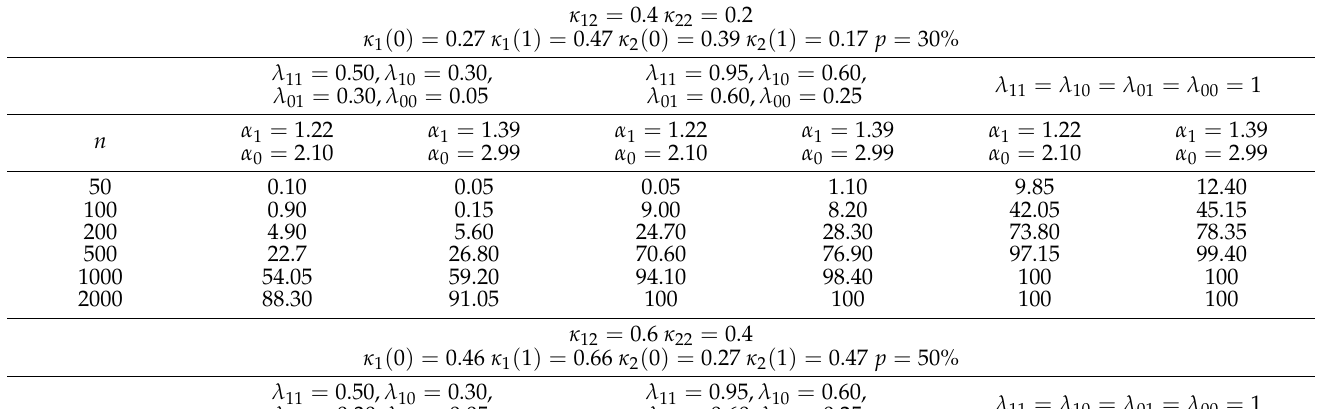
Table 6. Power (in %) of the hypothesis test when L > L (cid:48) (0.5 < c ≤ 1). κ 12 = 0.4 κ 22 = 0.2 κ